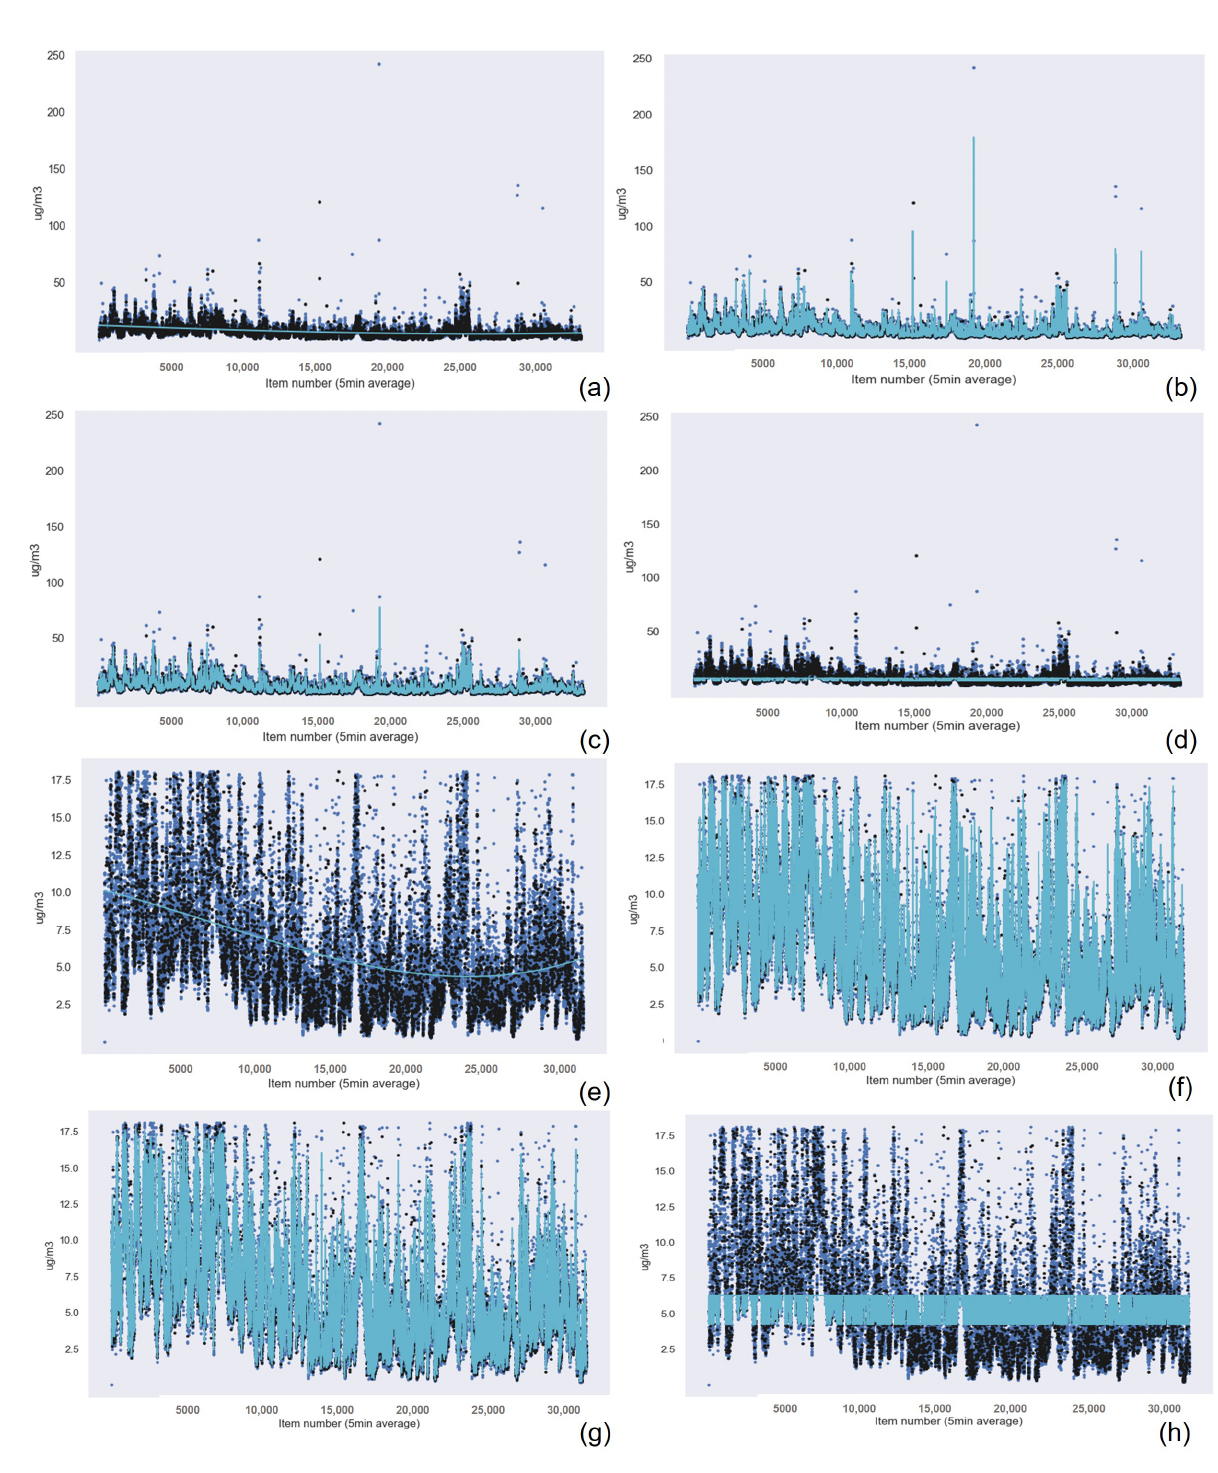
Figure A10. PM 2.5 results of the articulate matter measuring device # 1 with outliers for ( a ) Linear Re- gression ( b ) Random Forest Regression ( c ) KNN and ( d ) Support Vector Machine, and without outliers for ( e ) Linear Regression ( f ) Random Forest Regression ( g ) KNN and ( h ) Support Vector